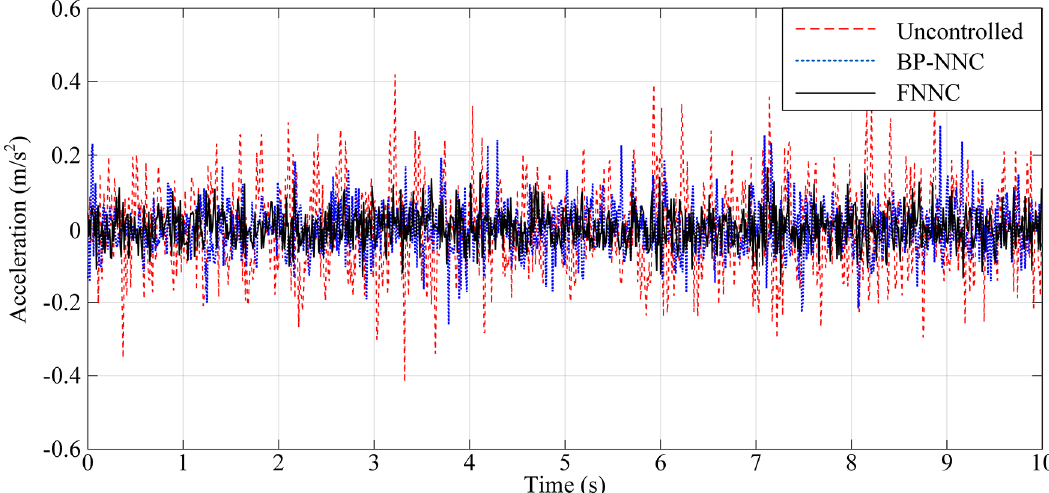
Fig. 26. Time-domain response of horizontal vibration acceleration of the elevator car frame with a medium load.